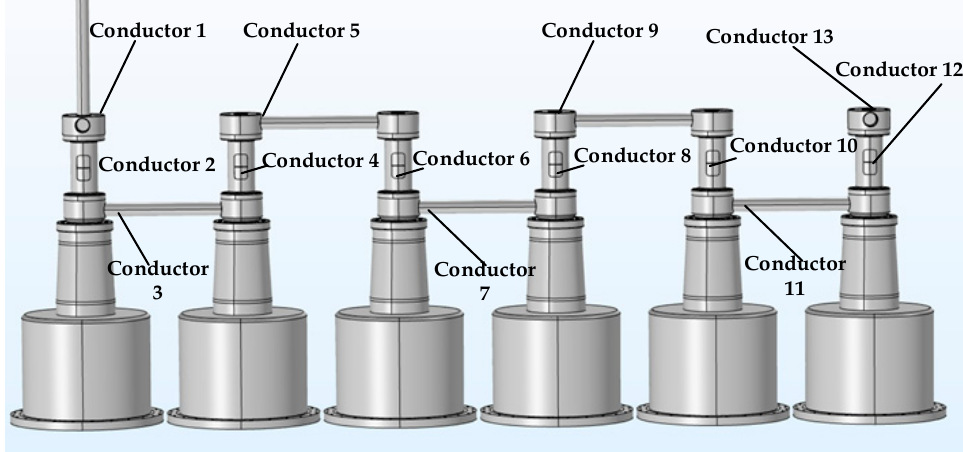
Figure 5. The conductor definitions.